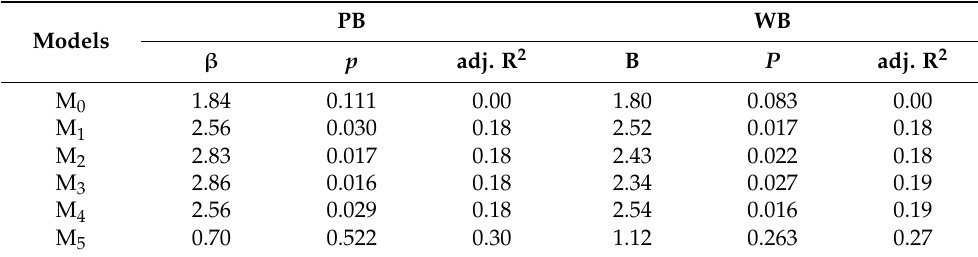
Table 4. Effect of being a woman on burnout in linear regression models. Models